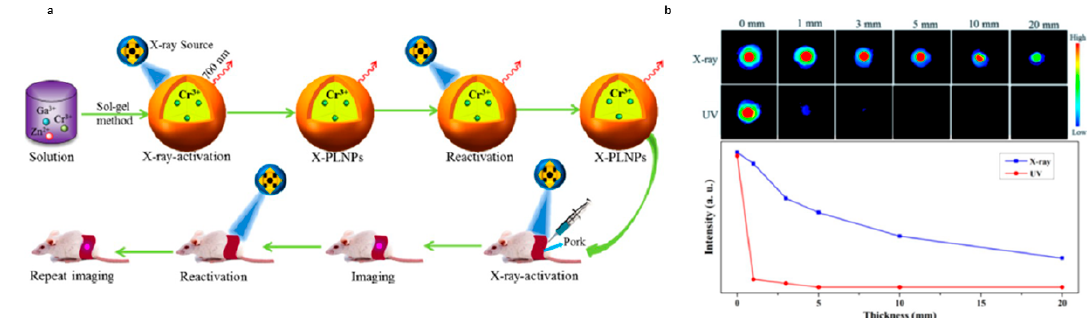
Figure 17. ( a ) Schematic diagram of in vivo PeL X-ray rechargeable luminescence imaging. ( b ) Phantom imaging as a function of time or pork tissue thickness (0, 1, 3, 5, 10, and 20 mm) using the PeL-NP ZnGa 2 O 4 :Cr 3 + . X-ray in vivo excitation for 5 min, at 45 kVp, or UV excitation prior to incubation for 20 min, at 365 nm. Reprinted with permission from [262]. Copyright (2017) American Chemical Society.